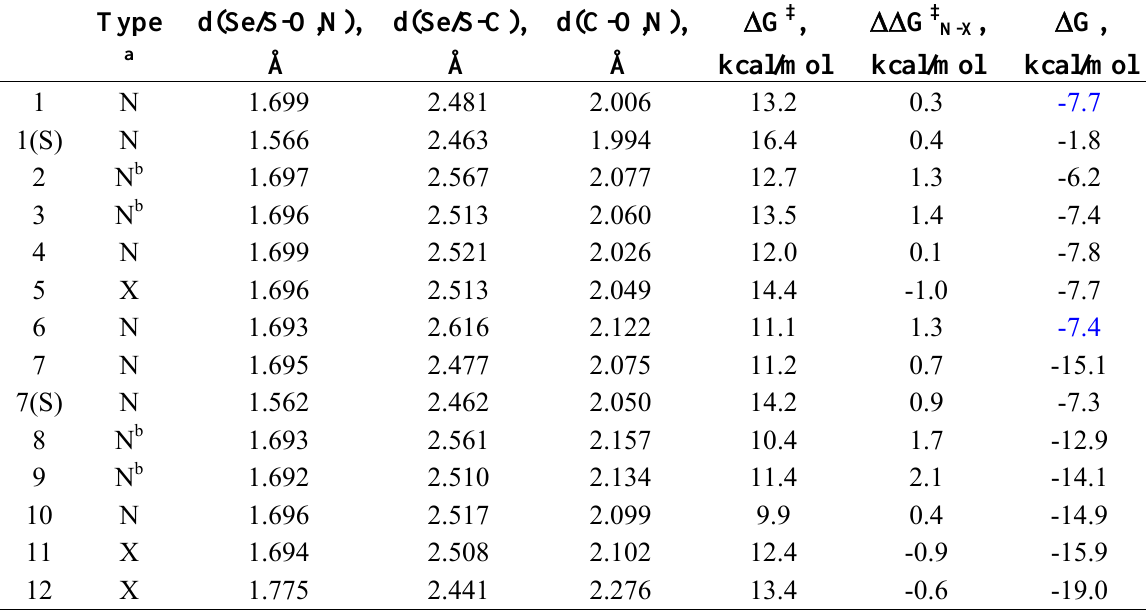
Table 1. Selected geometric parameters and activation barriers for the [2,3]-sigmatropic rearrangement of selenoxides 1 – 5